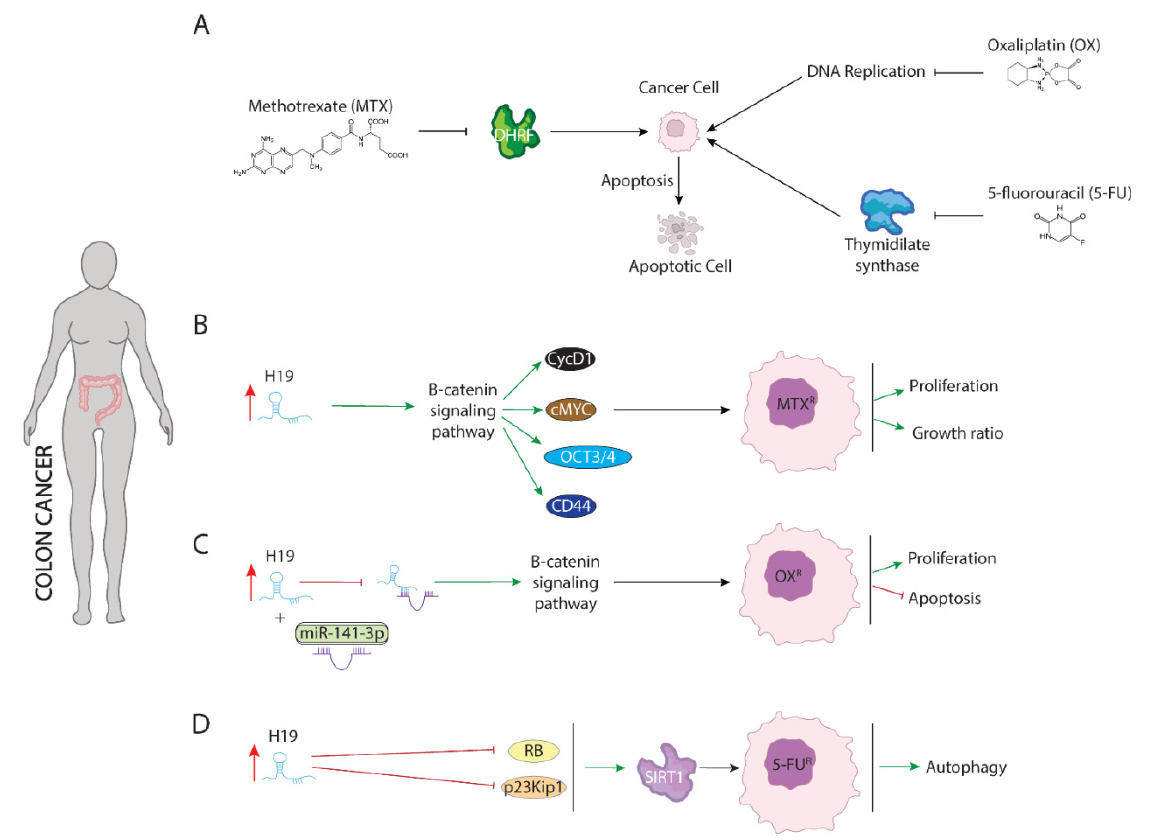
Figure 4. Schematic representation of molecular mechanism dependent of H19 function in colon cancer. ( A ) Mode action of methotrexate (MTX), oxaliplatin (OX), and 5-fluorouracil (5-FU) drugs involved in colon cancer treatment. ( B ) H19 modulate B-catenin signaling pathway genes such as CycD1 or cMYc increasing proliferation and growth ratio. ( C ) H19 acts as a sponge binding to miR-141 increasing expression B-catenin signaling pathway. ( D ) H19 blocking expression of RB and p23Kip1 leading to expression of SIRT1 which in turn, increases autophagy process.